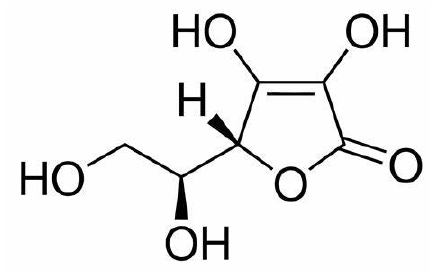
Figure 1. Structure of ascorbic